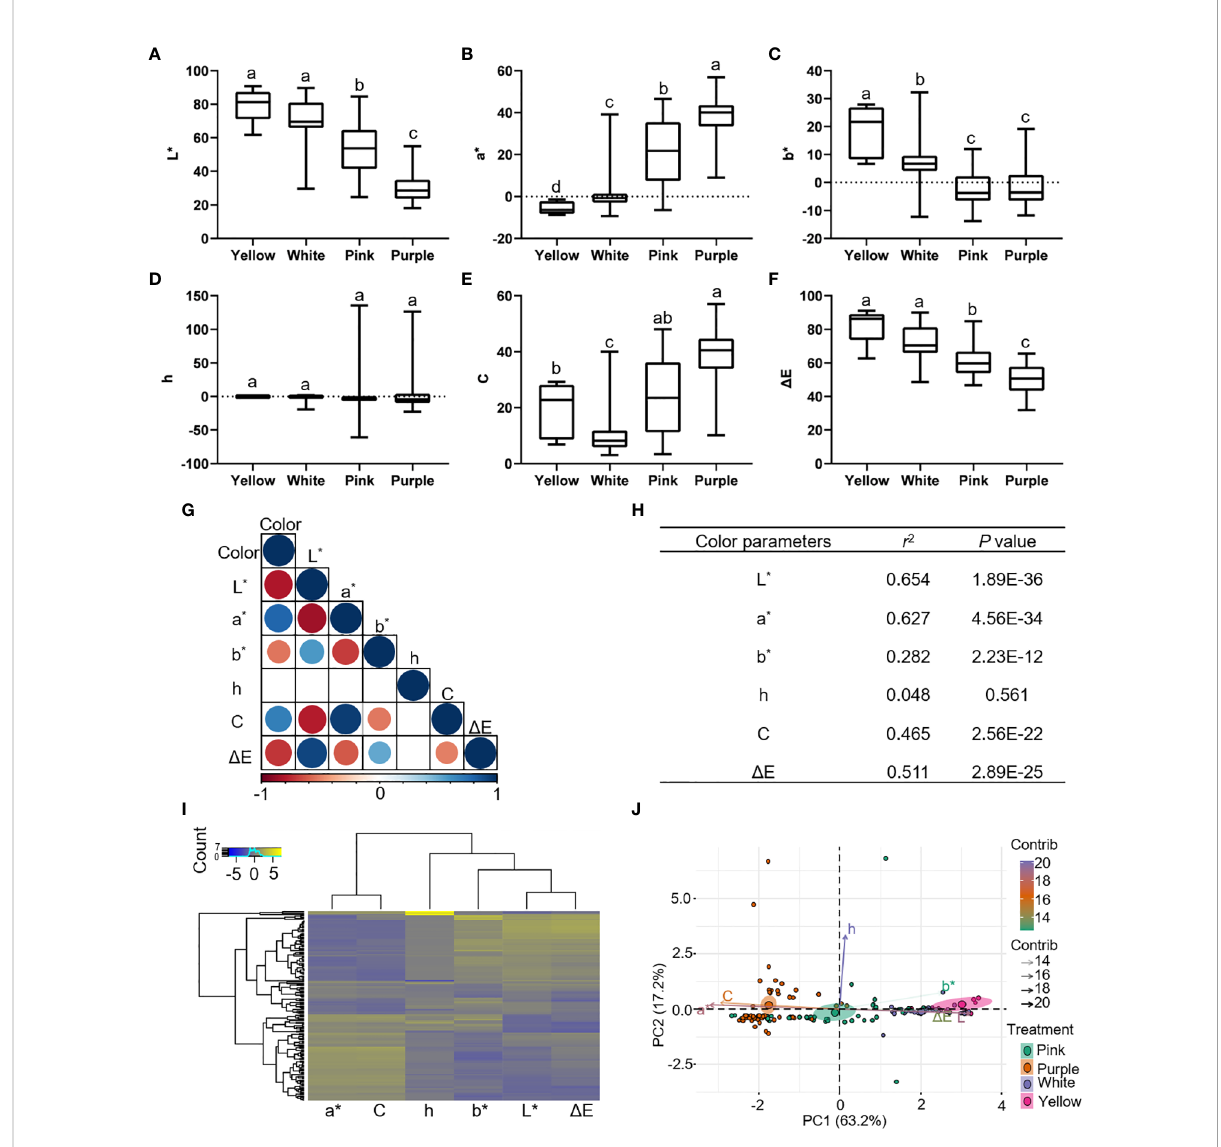
FIGURE 2 Color parameters of 159 P. lacti fl ora accessions. (A – F) Distribution of color indices in yellow, white, pink and purple groups. L*, a*, b*, h, C and D E represent the brightness, redness, yellowness, hue angle, chroma and hue, respectively. Results are expressed as means ± SD (n = 6). Different letters indicate signi fi cant differences at p < 0.05 according to Duncan ’ s new multiple-range test; ANOVA, analysis of variance. (G, H) Correlation analysis between color and color parameters. Clustering analysis (I) and principal component analysis (J) were used to analyze color parameters of 159 P. lacti fl ora samples. R programming is used for data